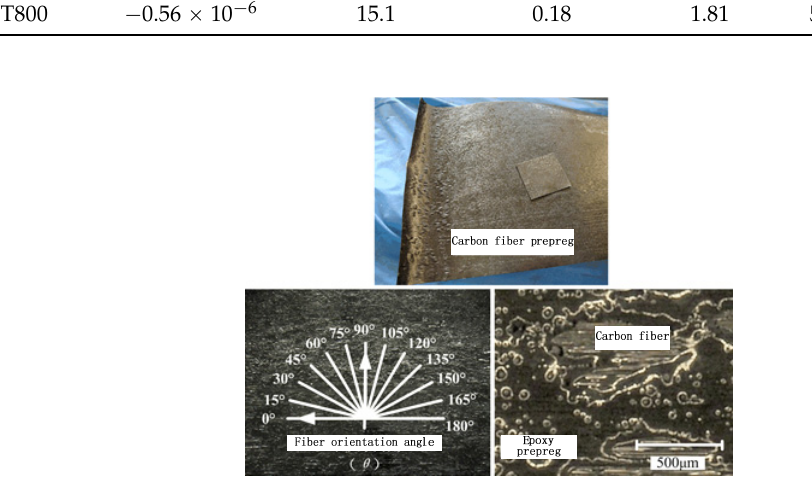
Materials 2015 , 8